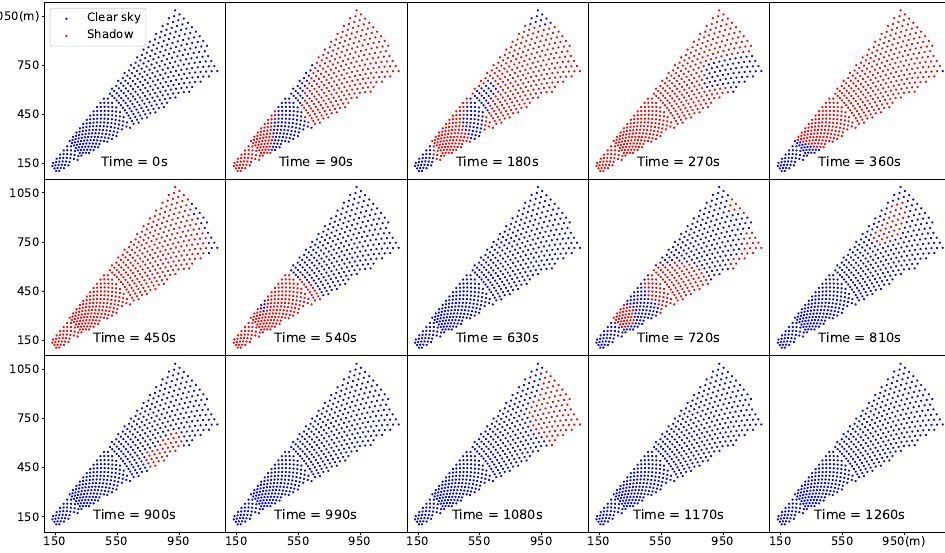
Figure 5. An example scenario of the shadows passing over the sector of the